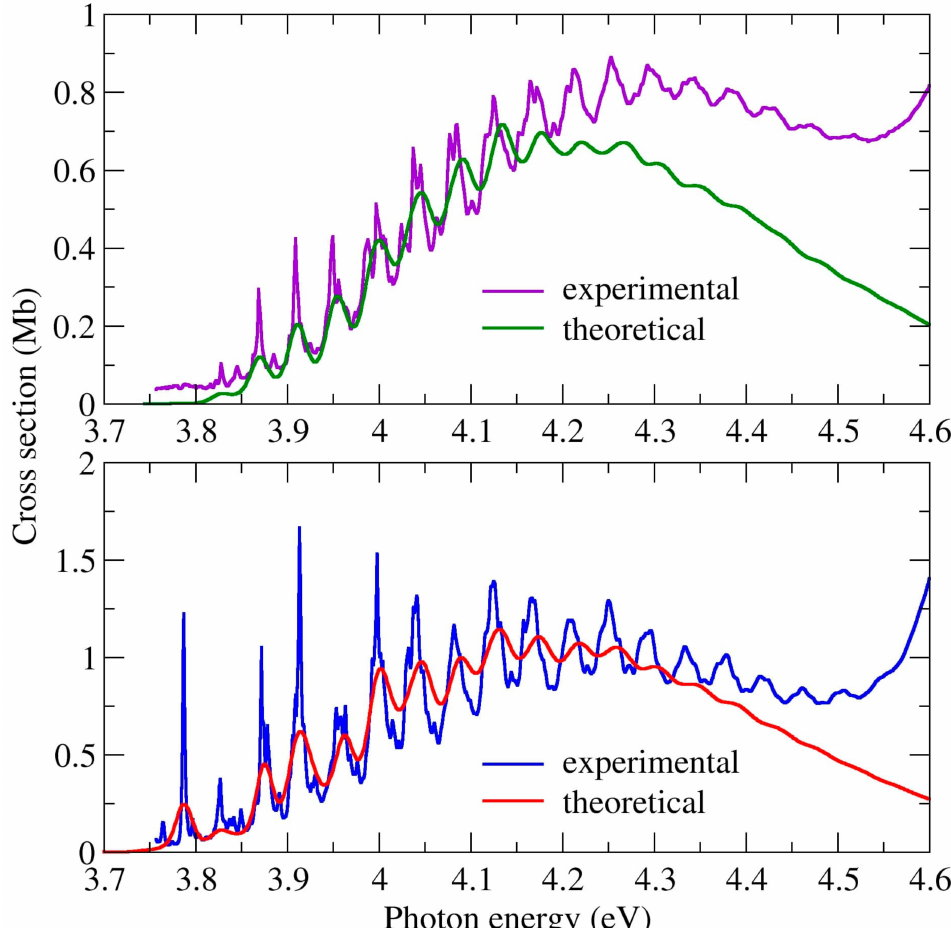
Figure 7. Comparison between measured and computed cross sections for the absorption Band I of 2-bromopyrimidine ( top panel) and 5-bromopyrimidine ( bottom